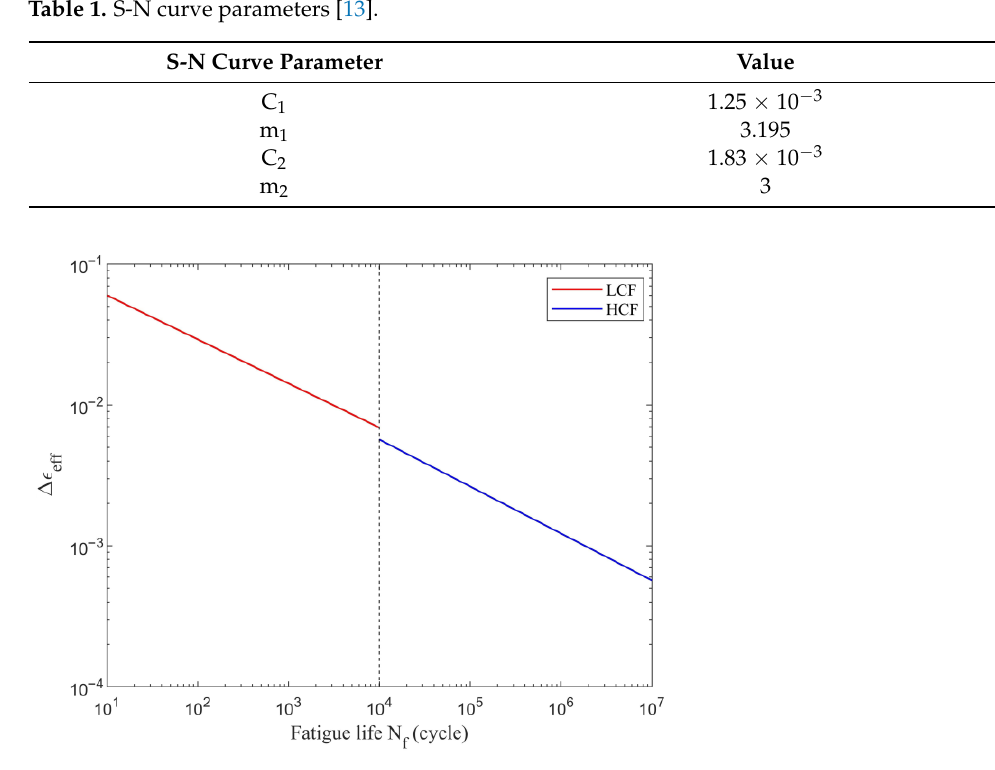
Figure 2. S-N curves for the effective notch strain approach [13].